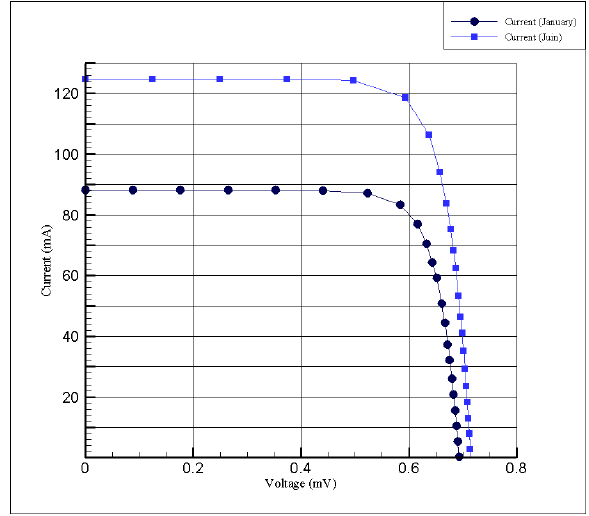
Figure 9. Open-circuit voltage and current testing graphs in January and June.